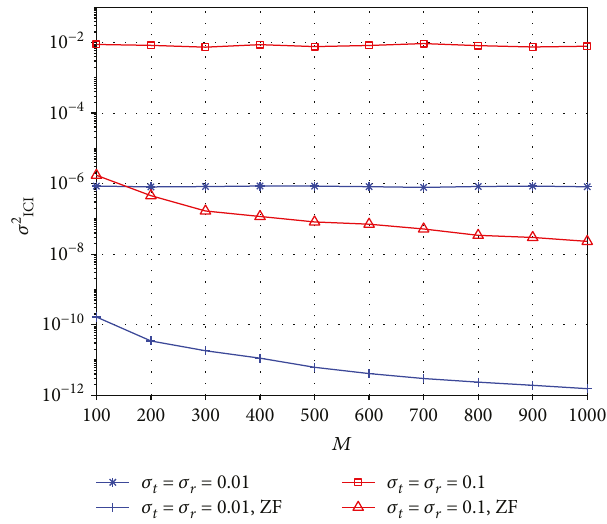
Figure 3: The ICI power comparison before and after ZF